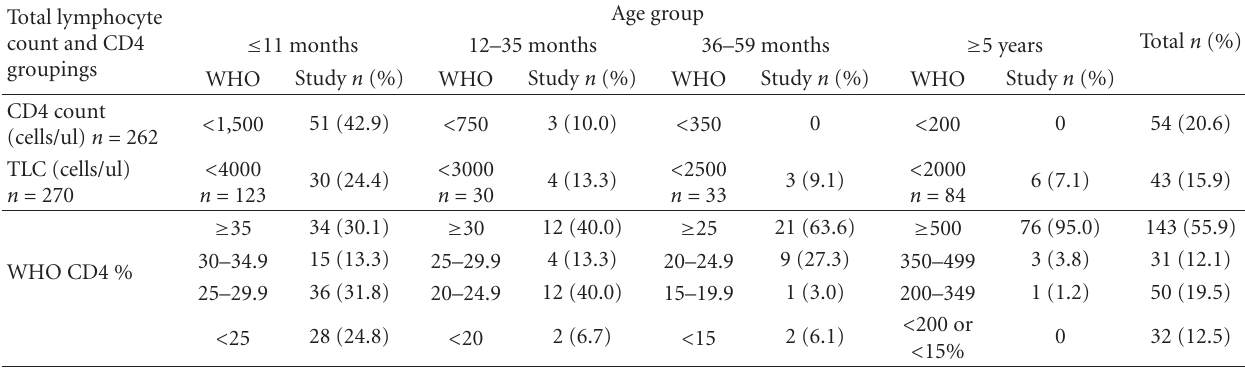
Table 3: Distribution of total lymphocyte count, CD4 count, and percentage using WHO cut-o ff values. Total